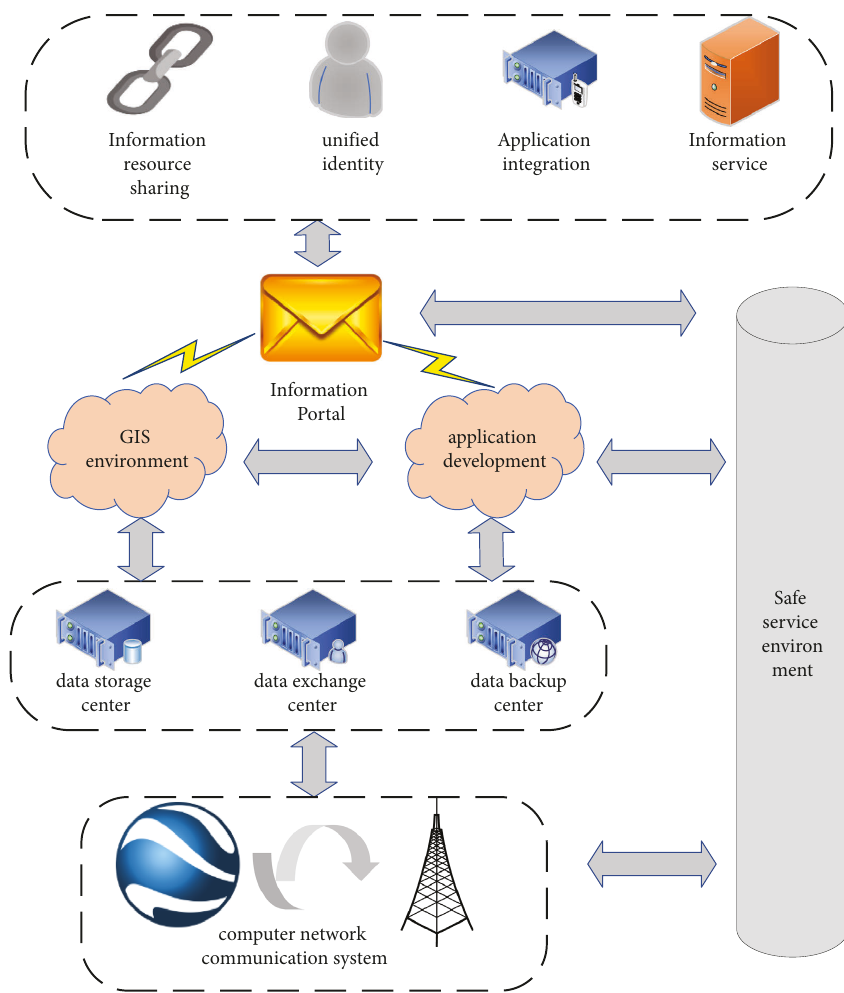
Figure 1: Framework design of the information resource management